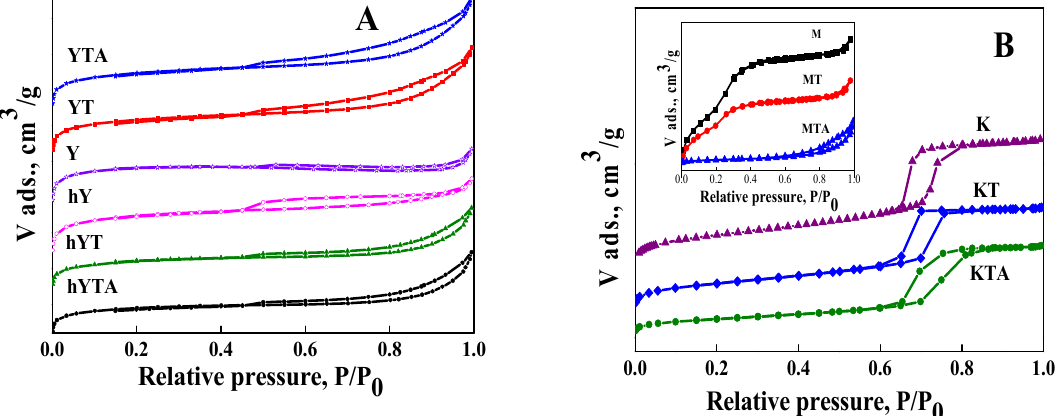
Figure 3. N 2 adsorption–desorption isotherms of the photocatalysts with zeolite Y supports ( A ) and mesoporous silica supports ( B ) MCM-48 (M) and KIT-6 (K). Conversely, a hysteresis loop came out after TiO 2 immobilization on zeolite Y (Figure 3A), very likely due to mesopores formed among TiO 2 nanoparticles. After gold immobilization on MT, the N 2 adsorption–desorption isotherm does not maintain the steep inflection at the relative pressure near P/P 0 0.25–0.3 as a support isotherm (inseted isotherms in Figure 3B), indicating that metalic species are not immobilized in the pores as an ideally homogeneous layer [30], but rather form deposits at their entrance and out of them. However, titania and gold immobilization caused a more significant decrease in pore volume (Figure 3B) of the MCM-48 support (MT and MTA samples), as opposed to the other mesoporous supports used, e.g., KIT-6. This is due to smaller pore size of MCM-48 compared to KIT-6, as depictable in Table S1, for 10% titania loading. Our previous study on MCM-48-supported catalysts [13] pointed out a smaller decrease in pore volume in conditions of a lower TiO 2 loading (5%). The zeolite-supported catalysts show a combination of type I and IV isotherms with H3 and H4 hysteresis loop [14]. The absence of the adsorption hysteresis for MCM-48 and Ti-MCM-48 samples is a result of their uniform pore distribution. Values of surface areas and pore size after each impregnation step are summarized in Table S1. Further immobilization of gold caused a BET surface increase for the